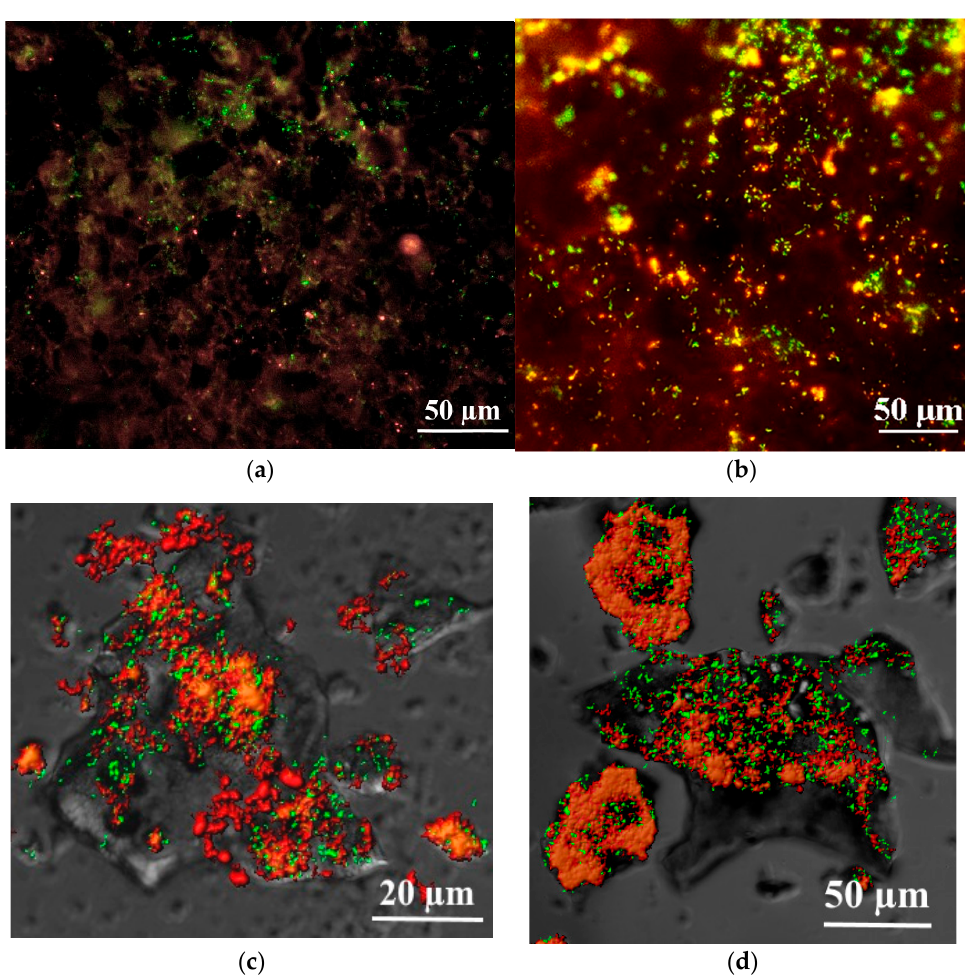
Figure 1. Micrographs of materials on the 20th day: zeolite–bio ( a ), zeolite–biomineralization ( b ), LECA–bio ( c ) and LECA–biomineralization ( d ). Red channel is polysaccharides, and green is nucleic acids. The area covered by cells (according to nucleic acid staining) on LECA was on average two times greater than that on zeolite (Table 3, which also contains data on the formation total covered area, in the case of zeolite, it was 53 ± 2.6% and for LECA, 84 ± 4.1%. The compared to